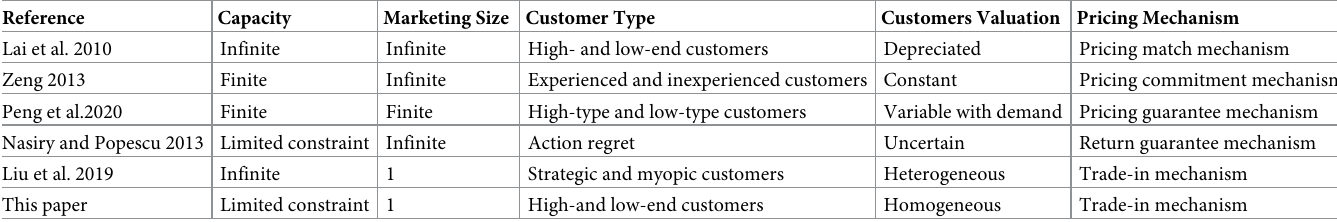
Table 1. Summary of research on pricing mechanisms with strategic